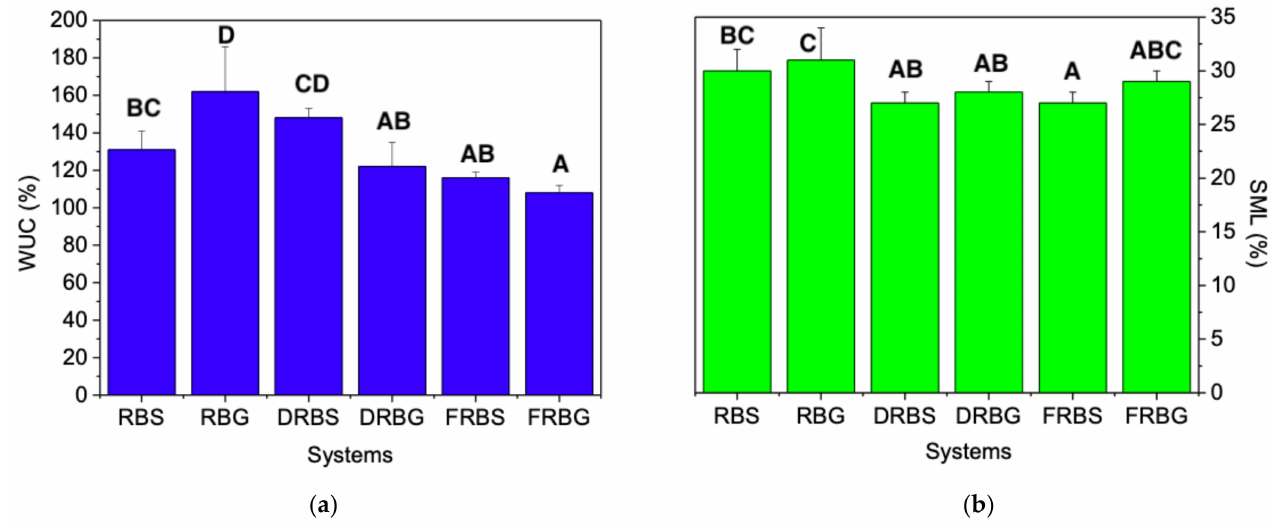
Figure 4. ( a ) Water uptake capacity (WUC) and ( b ) soluble matter loss (SML) of the different evaluated systems. Different letters above columns indicate significant differences ( p <